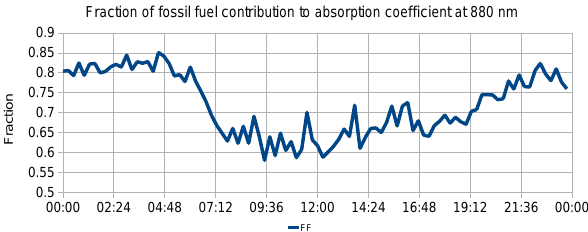
Fig. 7. Fraction of fossil fuel contribution to absorption coefficient.